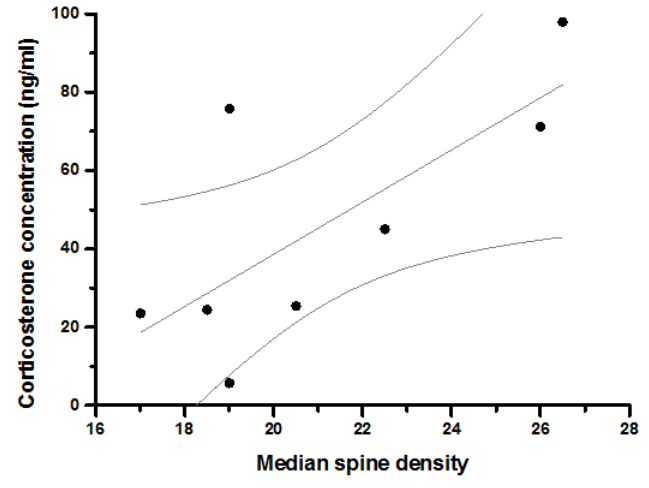
Figure 5. Correlation between spine density and corticosterone concentration. Abscissa depicts density of spines on primary shaft of basolateral amygdala neurons (median from a sample of eight neurons per animal; per 60 μ m). Ordinate depicts serum corticosterone concentration (ng/mL) thirty per animal; per 60 µ m). Ordinate depicts serum corticosterone concentration (ng/mL) thirty minutes minutes after exposure to the elevated plus ‐ maze. Best linear fit is also depicted with 95% confidence interval (R 2 = 0.46, slope = 6.6 ± 2.5; n = 8 animals; grey lines). (R 2 = 0.46, slope = 6.6 ± 2.5; n = 8 animals; grey Corticosterone concentration post ‐ EPM was positively correlated with trunk blood corticosterone obtained at the point of sacrifice. We did not observe a statistically significant correlation between corticosterone concentration post ‐ OFT and post ‐ EPM; collection points before and after intervening predator odor exposure (Table 2; rho = − 0.079, p = 0.83, β or probability of type 2 error at accepted α of 0.05 = 0.044). Similarly, open arm exploration in EPM was not significantly correlated with either corticosterone concentration (Table 2; rho = 0.633 and − 0.008, p = 0.067 and 0.98, for % entries and time in open arm, respectively) or architecture of BLA neurons ( rho = 0.097 to 0.360, p = 0.43 to 0.80). Correlation between BLA dendritic endpoints and corticosterone concentration post ‐ OFT (i.e., before cat odor exposure) also did not reach statistical significance.